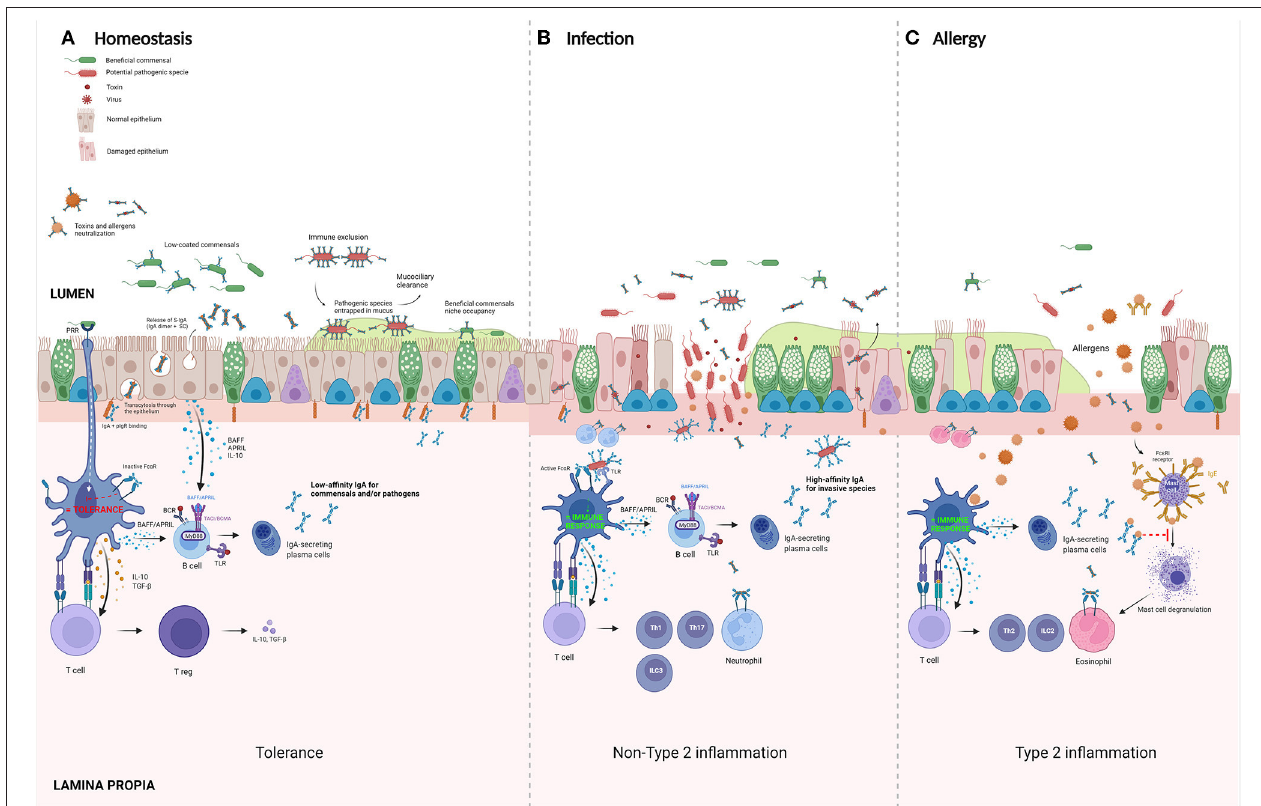
FIGURE 2 | Suggested roles of IgA in homeostasis and disease. (A) Homeostasis panel: commensal bacteria colonize mucosal surfaces of the respiratory tract. IgA-secreting plasma cells produce IgA that binds microbes with low affinity, preventing exclusion of coated bacteria. In this way, IgA coating controls the composition of the microbiome by promoting growth of beneficial commensals. Isolated activation of Fc α R on dendritic cells (DC) induces tolerance via the activation of T regulatory cells. (B) Infection panel: pathogens that penetrate the epithelial layer will be opsonized by local dimeric IgA (dIgA) present in the subepithelial space. These antibody-opsonized pathogens will activate DC by a double stimulation of both Fc α RI and pathogen-recognition receptors (PRR), such as Toll-like receptors (TLRs). This costimulation turns tolerogenic DCs into pro-inflammatory cells which induce an active adaptive immune response by activating T helper (Th) 1, Th17, and type 3 innate lymphoid cells (ILC). (C) Allergy panel: in atopic individuals, the uptake of allergens by DC results in an induction of a type 2 inflammatory environment with the induction of Th2 cells and activation of ILC2 with an influx of eosinophils and production of antigen-specific IgE. In these sensitized individuals, re-exposure to allergens causes a cross-linking of mast-cell bound IgE on mast cells, leading to their degranulation. Secretory IgA (S-IgA) is known to bind and activate eosinophils and might promote this Th2 response. However, antigen-specific IgA is believed to act as a scavenger for allergen, preventing binding to its specific IgE. In the pre-sensitization phase, antigen-specific S-IgA is believed to play an important role in inducing allergenic tolerance. BAFF, B cell activation factor; APRIL, A proliferation inducing ligand; TSLP, thymic stromal lymphopoietin; PRR, pattern-recognition receptor; IgA-IC, IgA-immune complexes. Created with